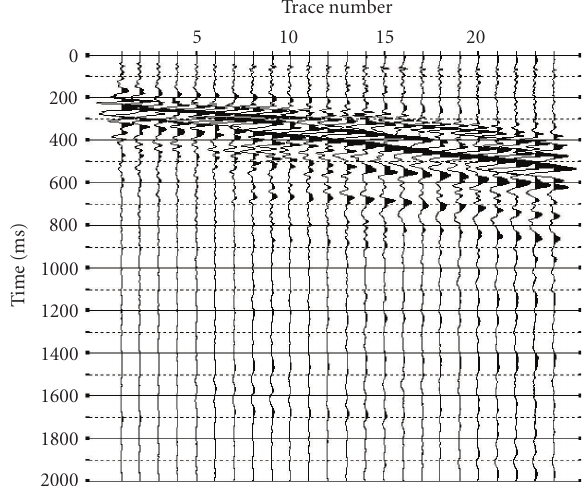
Figure 2: Sample shot gather from the MASW method for the Brantwood site located around the Rideau Canal of Ottawa.